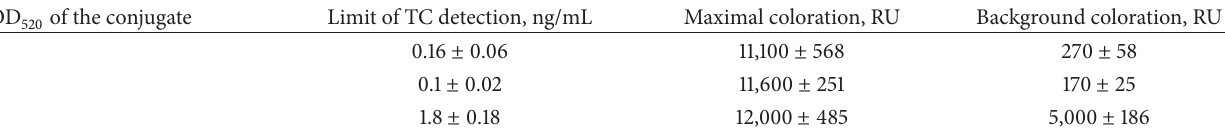
Table 2: The dependence of TC immunochromatographic assay on IgG-GNP conjugate concentration.